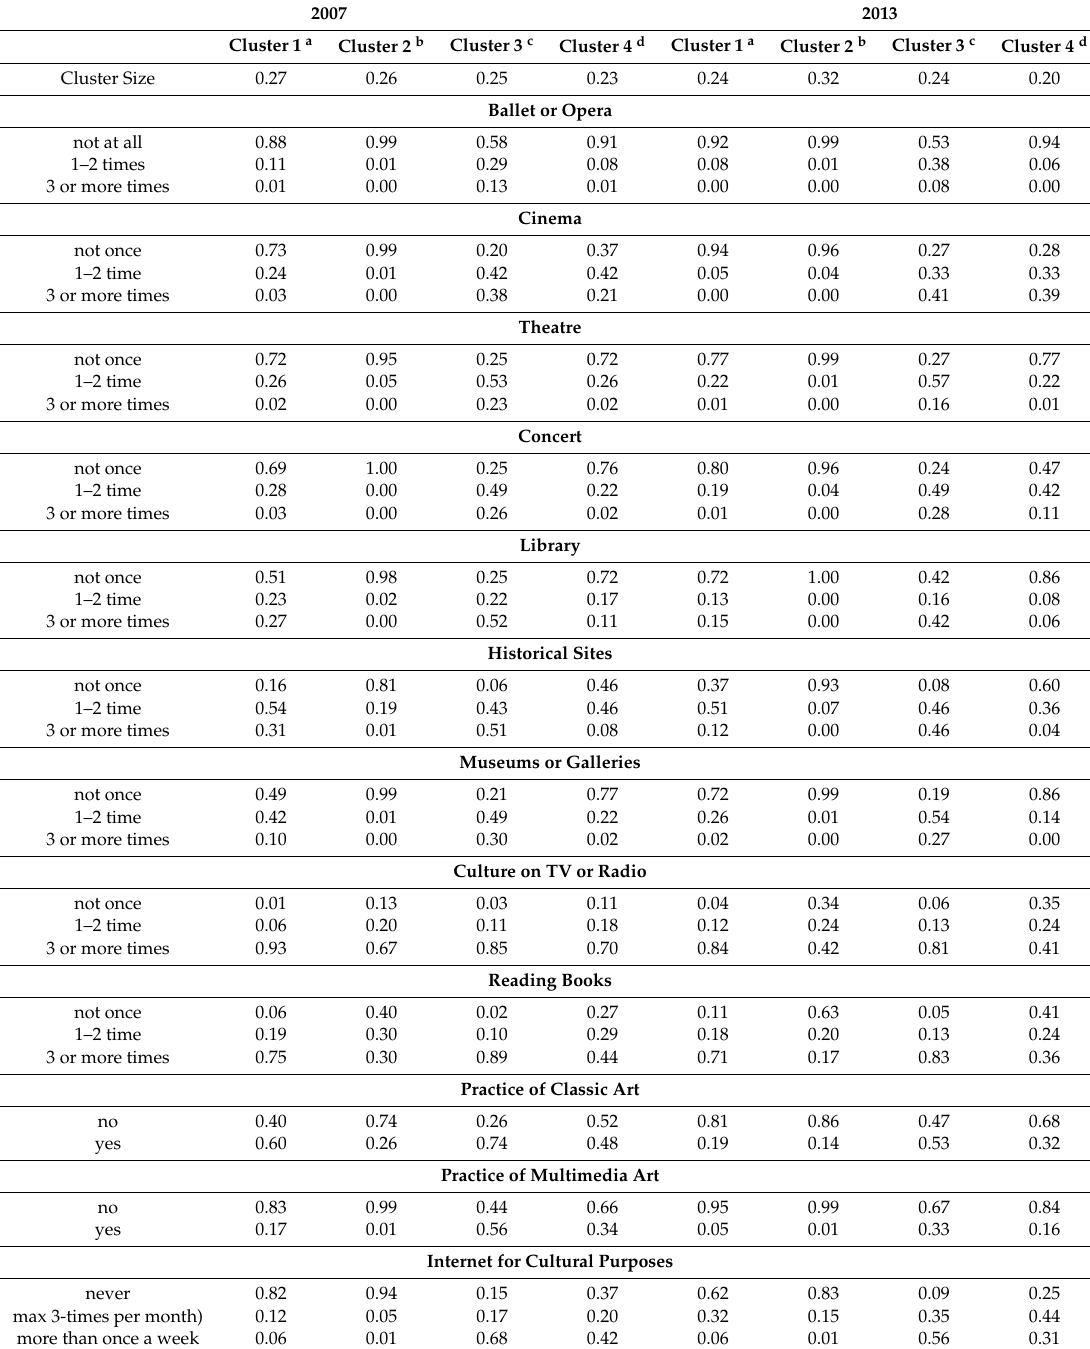
Table 3. Conditional Probabilities of Belonging to the Cluster Based on Frequency and Type of Cultural